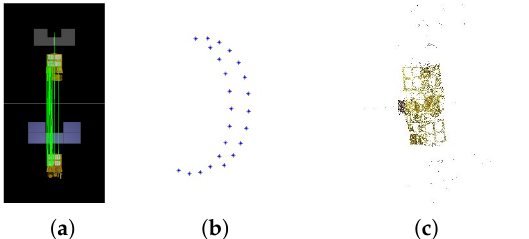
Figure 2. Incorrect reconstruction caused by symmetric structures and repeated textures. ( a ) Matches; ( b ) poses; ( c ) point cloud.